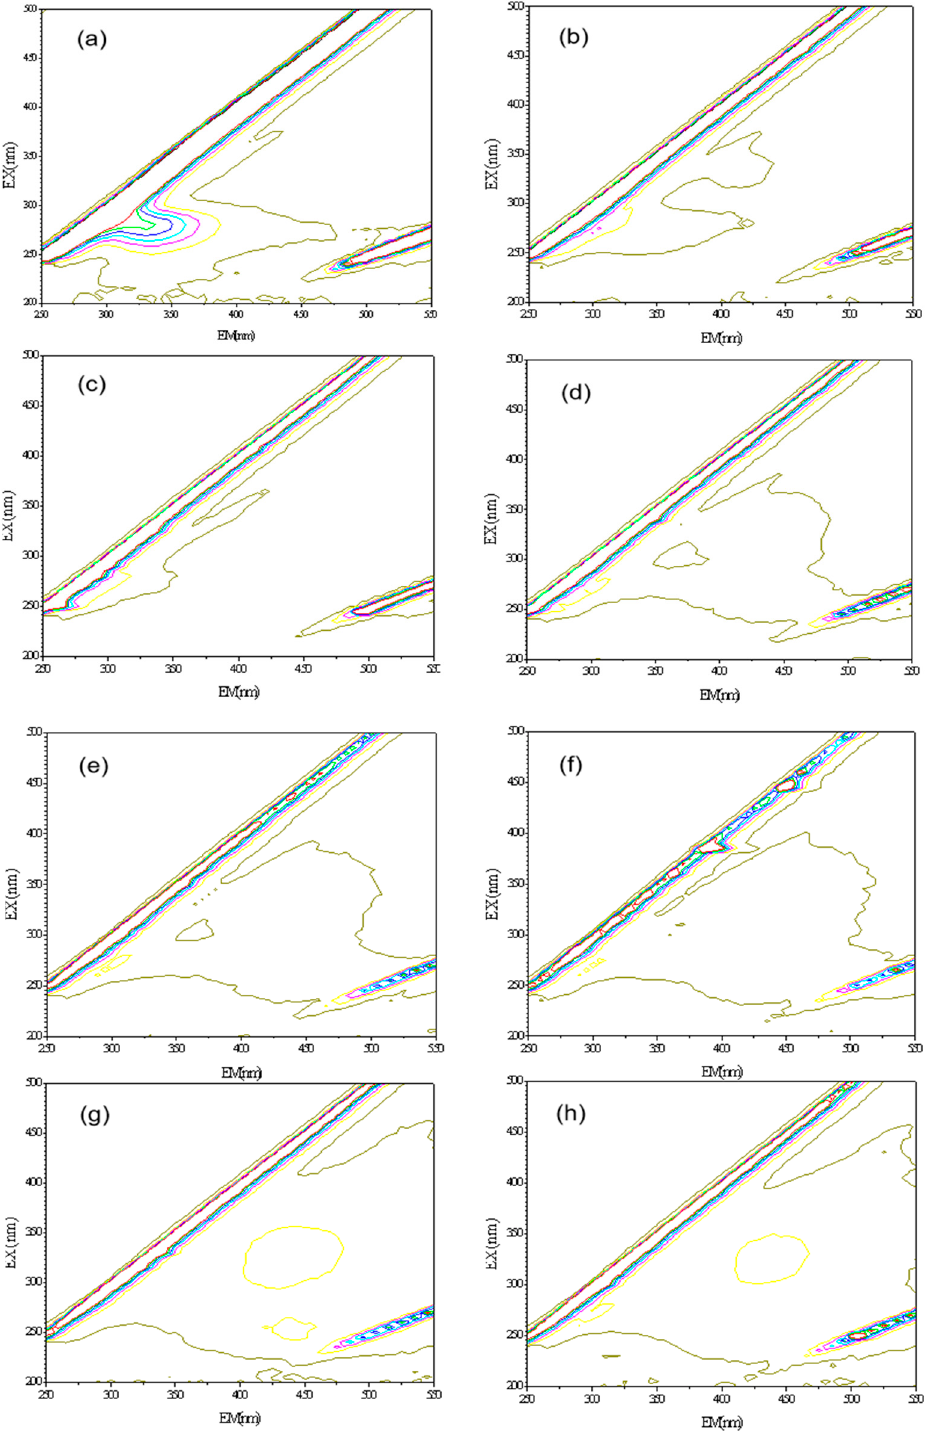
Figure 3. 3D-EEM spectrum of EPS. ( a – h ) Particle concentration of 0, 100 mg/L, 200 mg/L, 400 mg/L, 800 mg/L, 1000 mg/L, 1200 mg/L, and 1400 mg/L, respectively. The atlas of EPS extract obtained from 3D-EEM scanning of R2A liquid medium cultured and treated at different rotational speeds is shown in Figure 4.